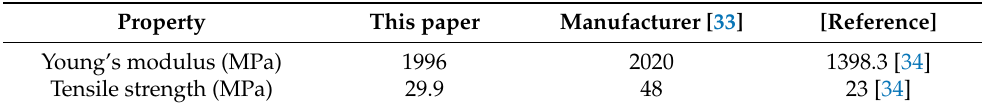
Table 4. Comparison of basic mechanical properties of ASA+ specimens.